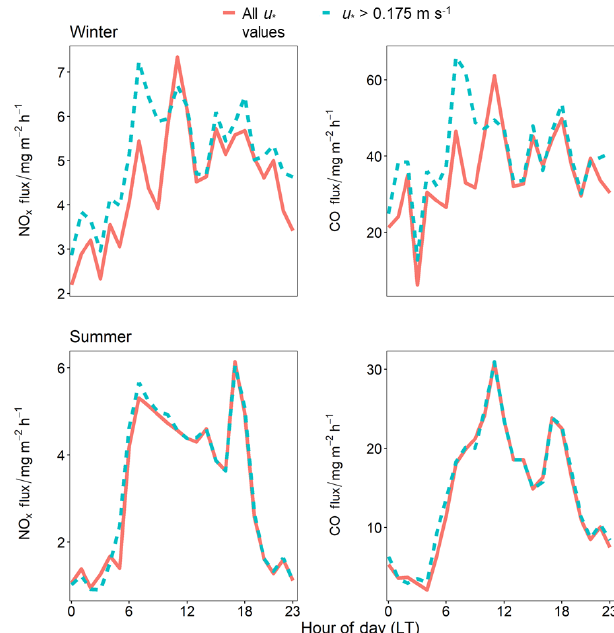
Figure A2. Comparison between diurnal variation in NO x and CO fluxes for all u ∗ values and for u ∗ values over